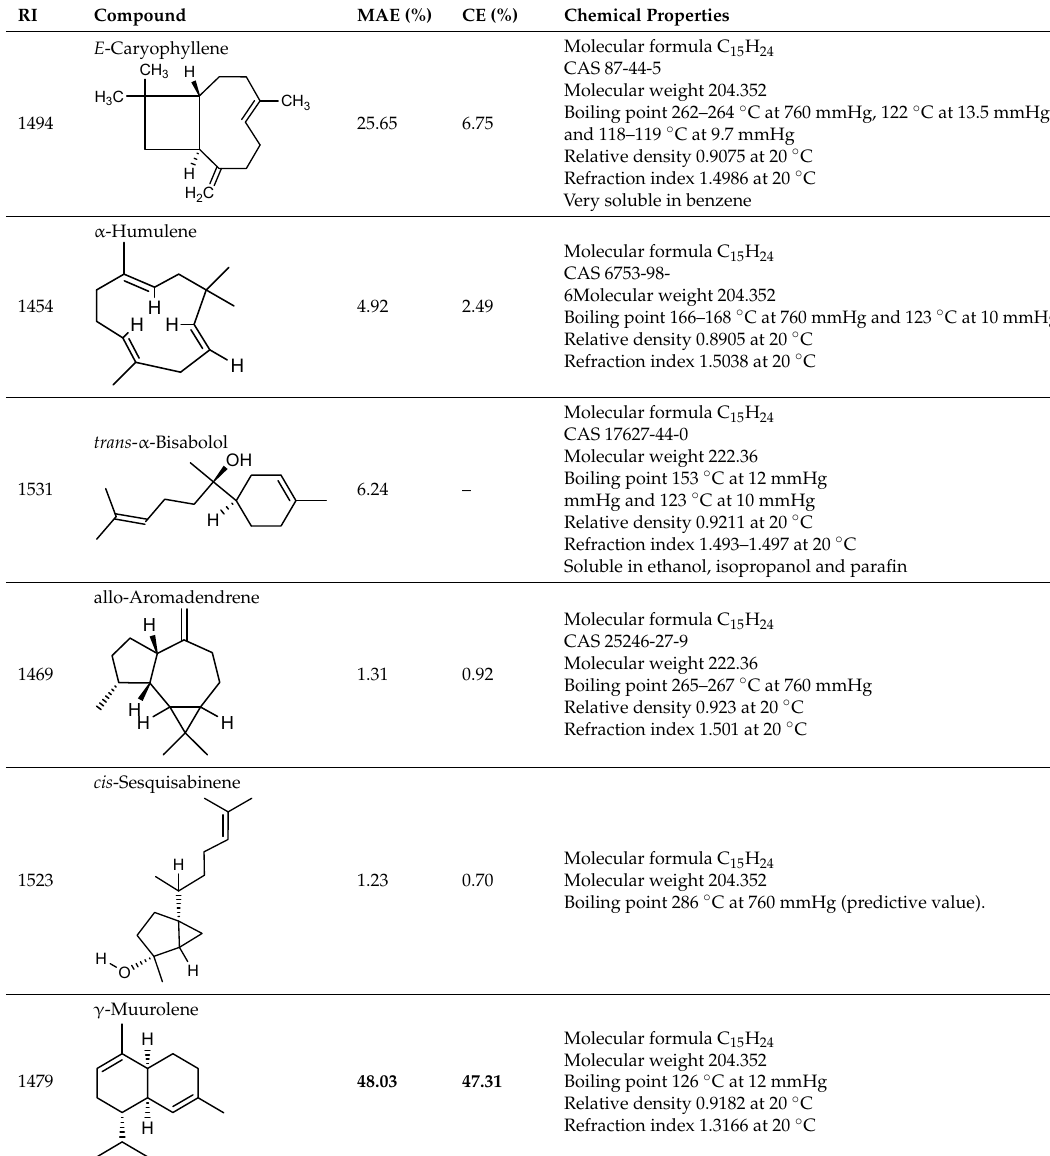
Molecular formula C 15 H 24 Molecular weight 204.352 48.03 47.31 Boiling point 126 °C at 12 mmHg Relative density 0.9182 at 20 °C Refraction index 1.3166 at 20 °C